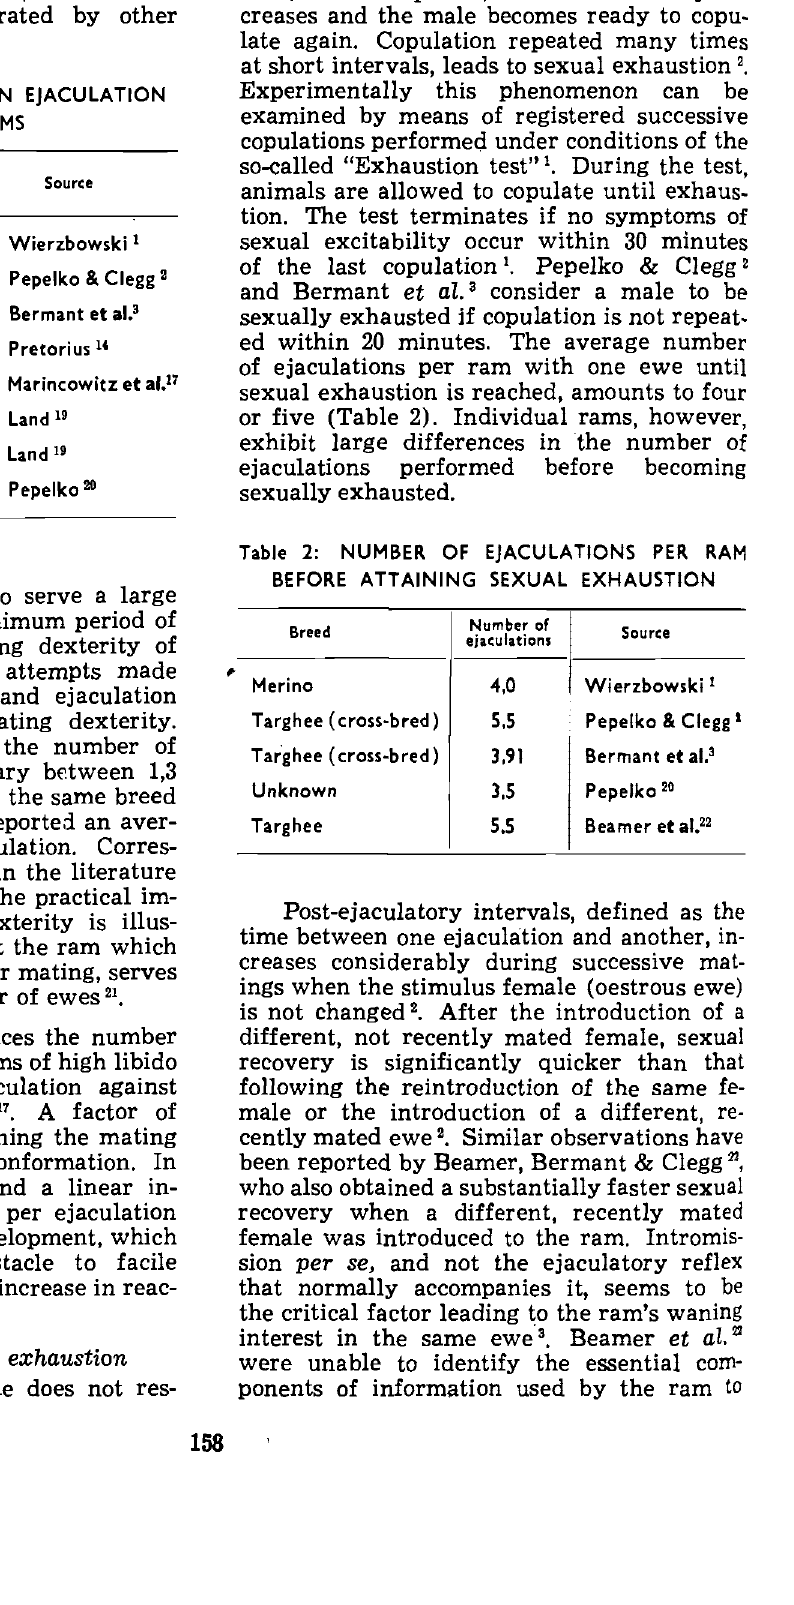
Table I: BREED DIFFERENCES IN EJACULATION